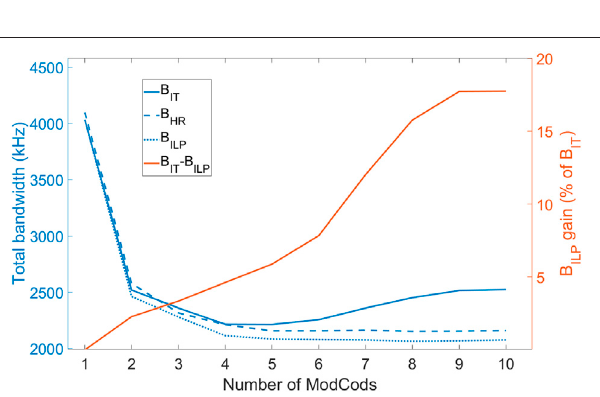
Frontiers in Communications and Networks |